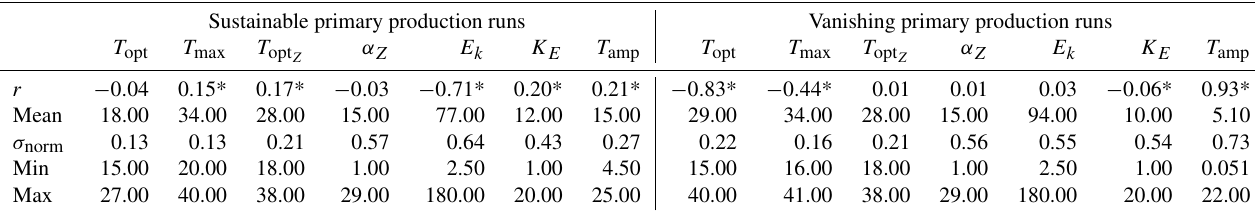
Table 5. Metrics obtained from the Monte Carlo sensitivity analysis on the simulated annual primary production of MPB. Sustainable primary production runs Vanishing primary production runs